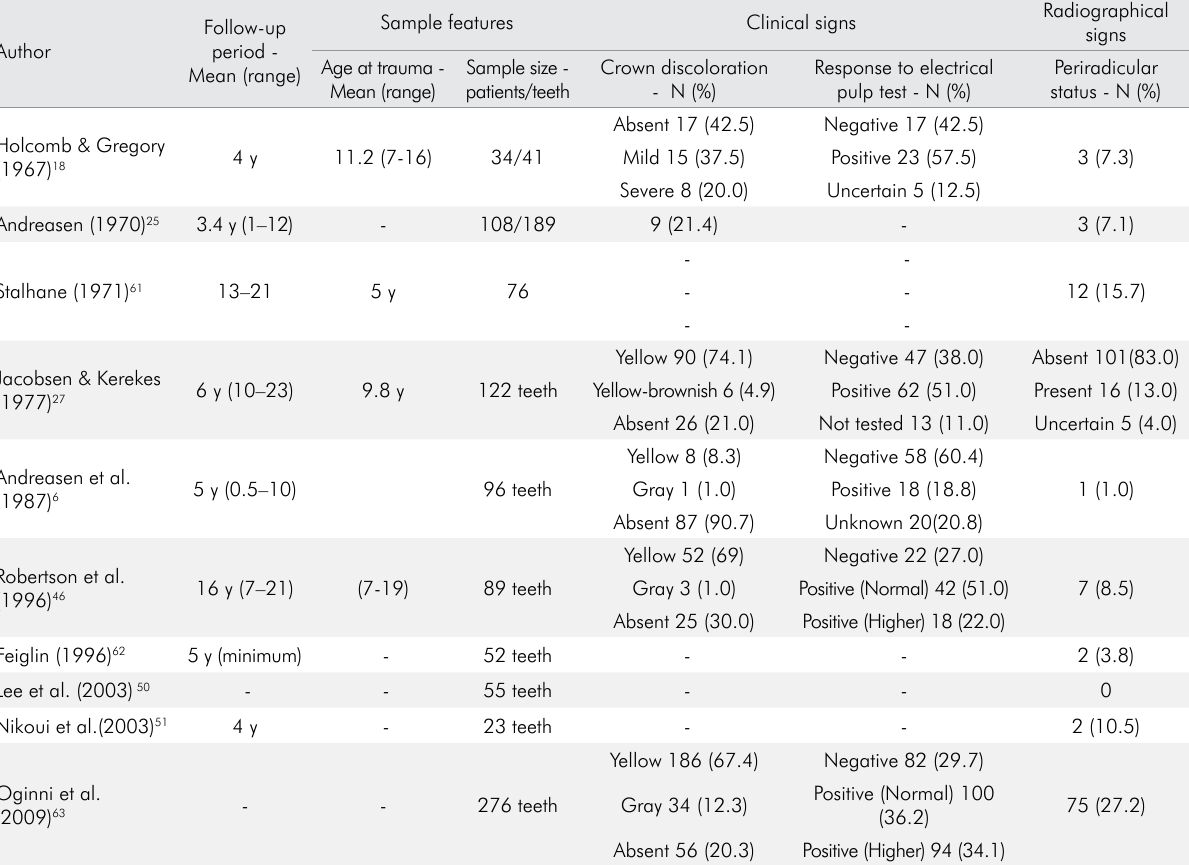
Table 2. Prevalence of crown discoloration and pulp necrosis in teeth with PCO after TDI: clinical reports.